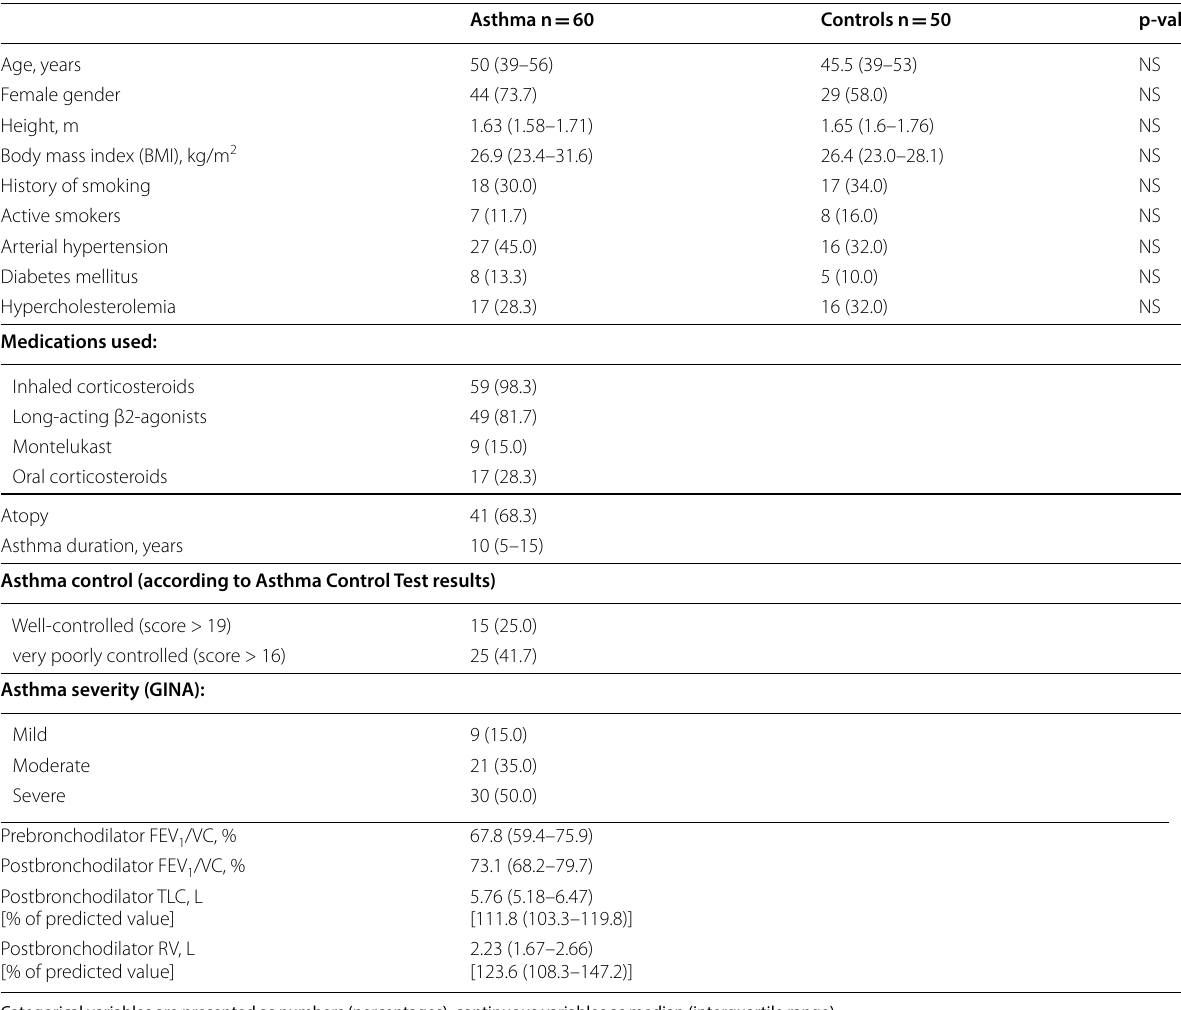
Table 1 Clinical characteristics of subjects